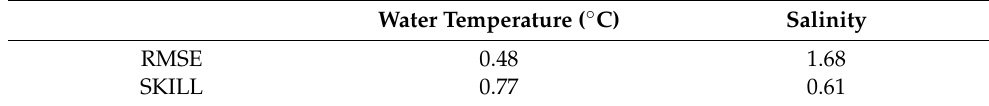
Table 3. Water temperature and salinity performance resulting from the